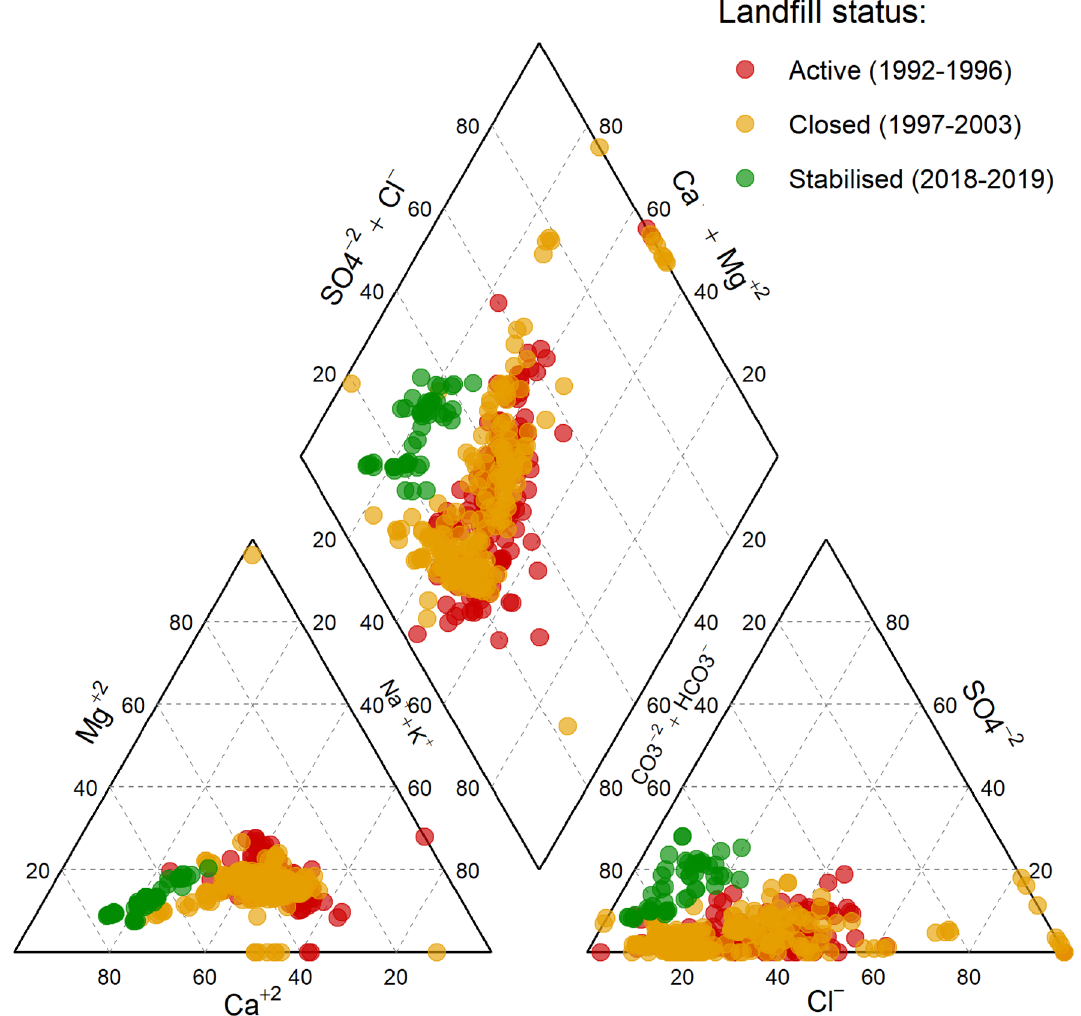
Figure 5. Characteristics of groundwater chemistry based on levels (% meq/l) of calcium, magnesium, potassium, sodium, chloride, sulphate and bicarbonate categorised by the landfill status (active, closed and stabilised). The years in parenthesis denote the periods for which groundwater chemistry data for classifying water types were available; otherwise, “closed” should span the period 1997–2016, while “stabilised” should cover